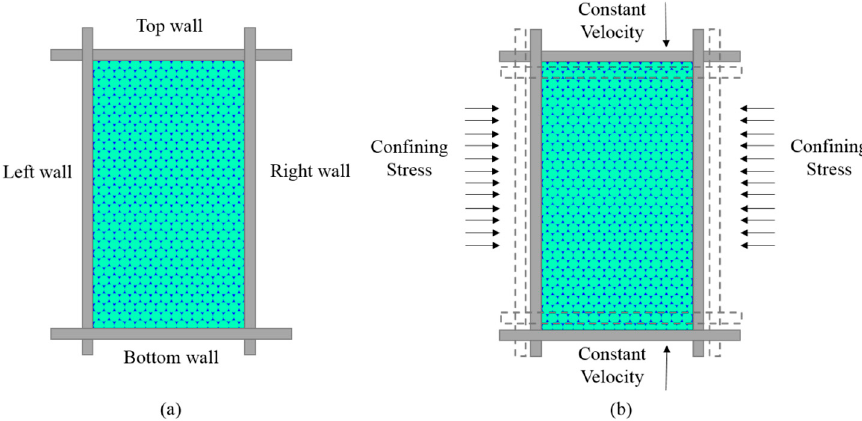
Figure 5. The DEM sample for biaxial compression simulation. ( a ) The hexagonal packing of the granular media; ( b ) the boundary condition for biaxial compression simulation.